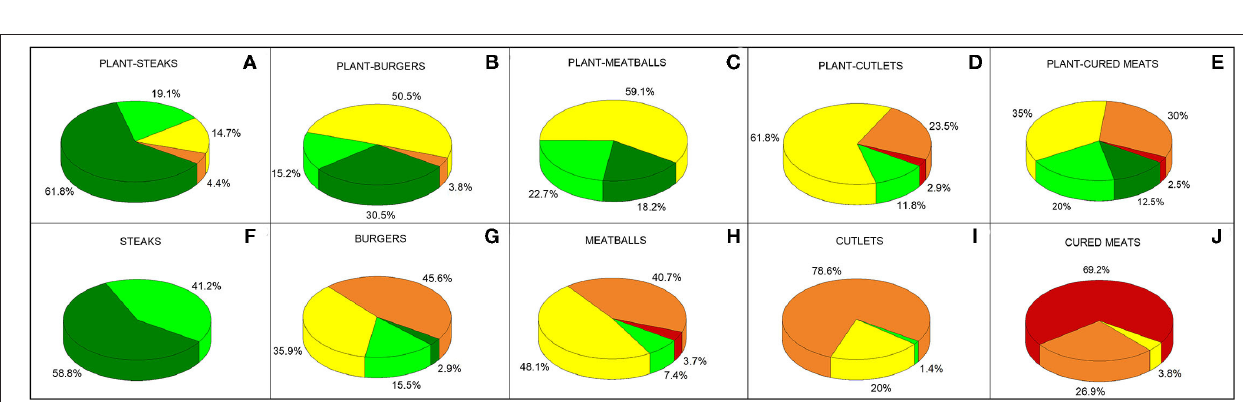
Frontiers in Nutrition |